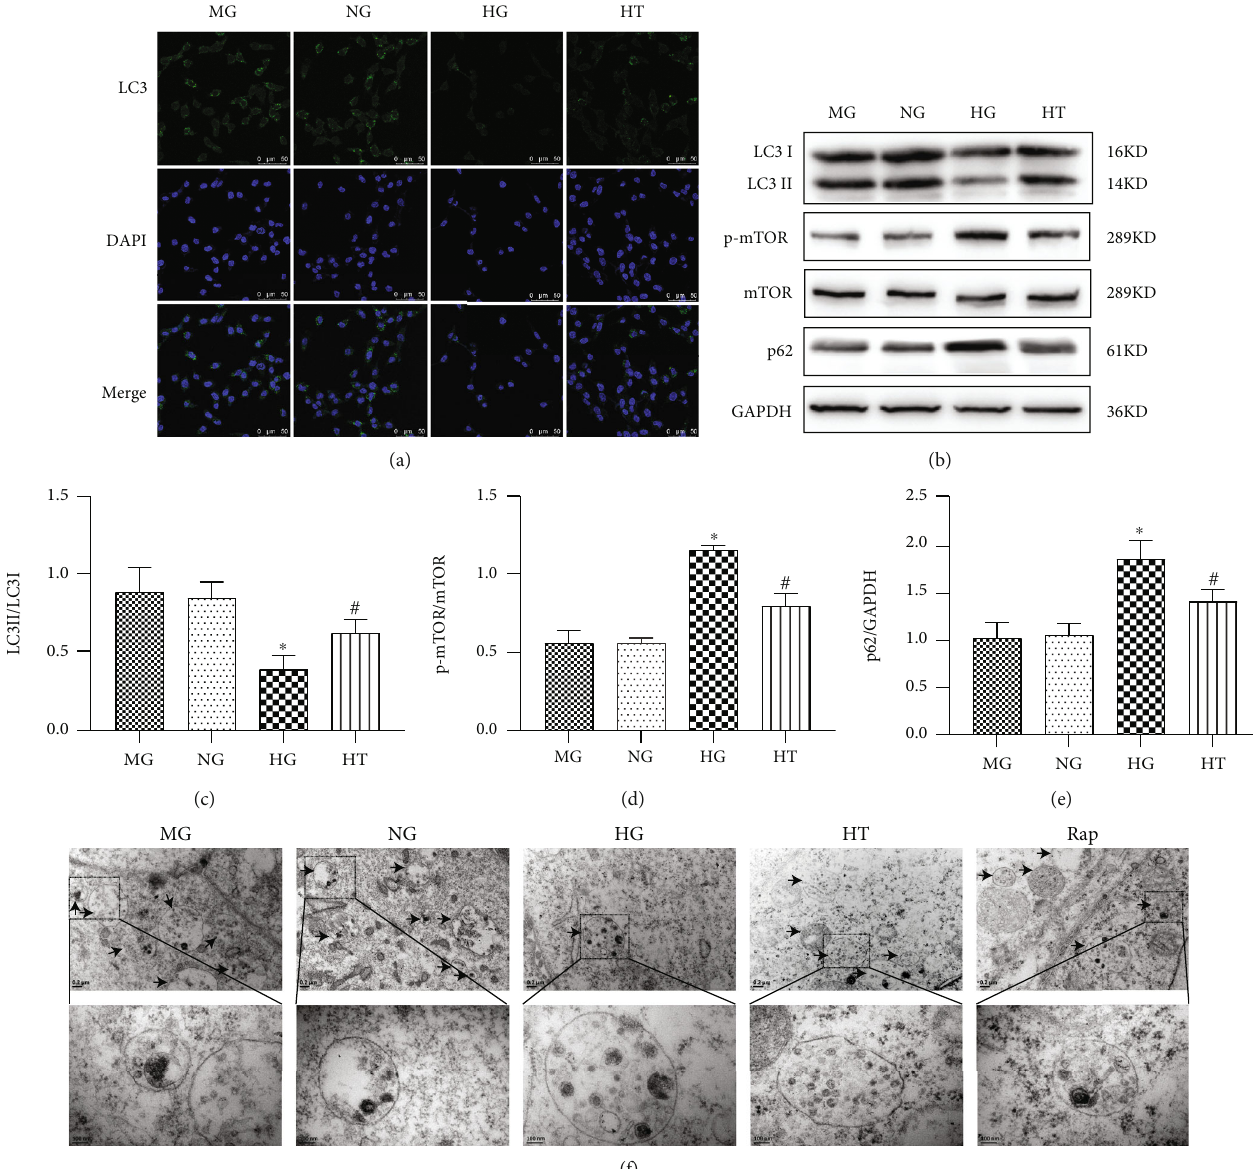
Figure 5: E ff ect of TSN on the autophagic activity of high glucose-induced podocytes. (a) Representative immuno fl uorescence photographs (magni fi cation × 630) of LC3II in each group ( n = 3 ). Scale bar =50 μ m. (b – e) Representative Western blot bands and quanti fi cation of LC3II/I, p-mTOR, mTOR, and P62 protein expression. Data were shown as mean ± SD , n = 3 ; ∗ P < 0 : 05 versus the NG group, # P < 0 : 05 versus the HG group. (f) Electron microscope observation showed that the number of autophagosomes decreased under high glucose conditions, and TSN treatment could improve it. The scales and magni fi cations are 0.2 μ m and × 6000 for the upper picture and 100nm and × 20000 for the lower